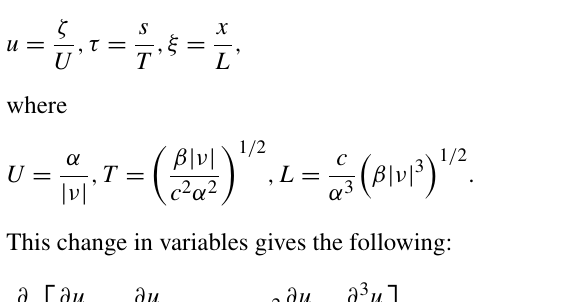
(2015), in the rotating Gardner